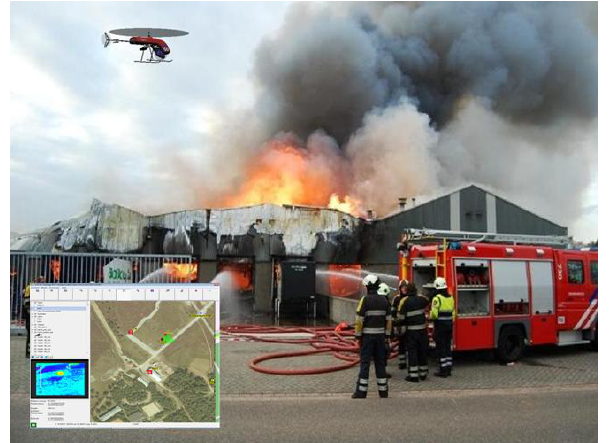
Figure 1. Flexible eye in the sky to support fire